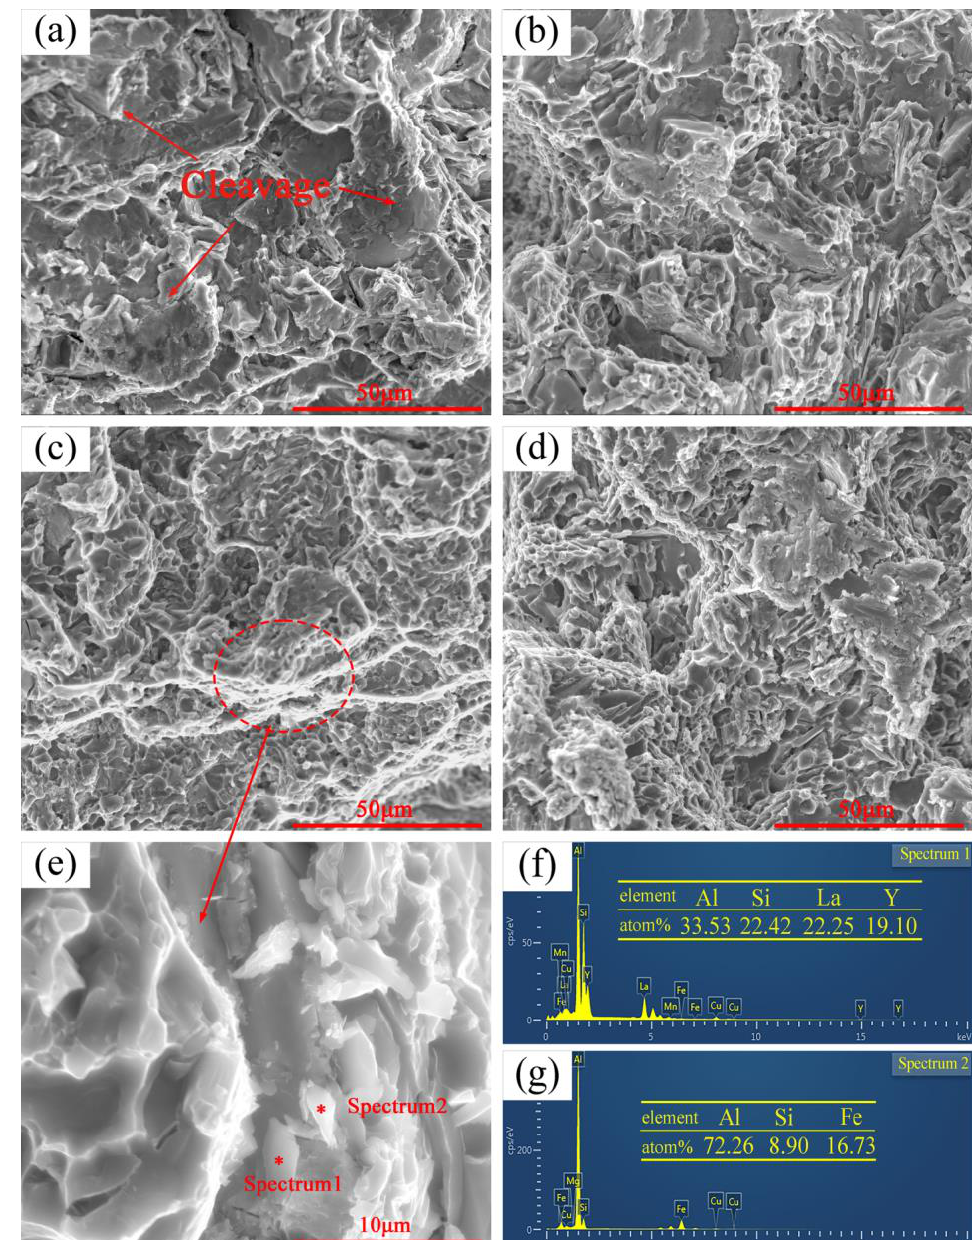
Figure 7. SEM of fractures of cast A380 alloys with different (La+Y) contents: ( a ) matrix alloy; ( b ) 0.3 wt.%; ( c ) 0.6 wt.%; ( d ) 0.9 wt.%; ( e ) enlarged view of the selected area in ( c ); ( f ) elemental point scan at point 1; ( g ) elemental point scan at point